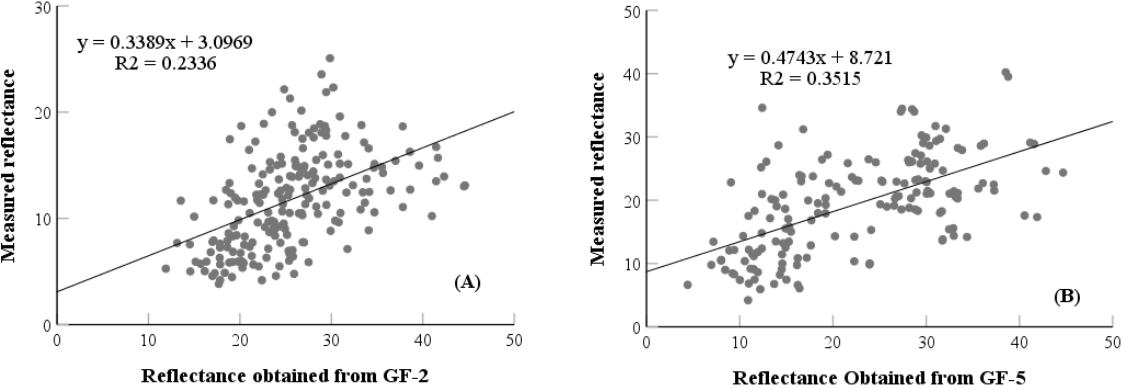
Figure 11. Scattering plot between reflectance measured and obtained from remote-sensing data of GF-2 and GF-5. ( A ) Scattering plot of GF-2; ( B ) scattering plot of GF-5.